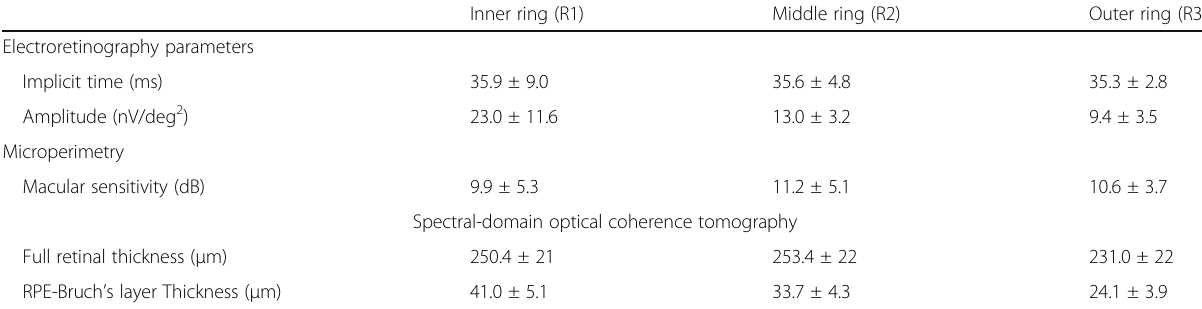
Table 1 Mean values of the multifocal electroretinography, microperimetry, and retinal layer thicknesses obtained using spectral- domain optical coherence tomography among subjects with birdshot chorioretinopathy included in the study Inner ring (R1) Middle ring (R2) Outer ring